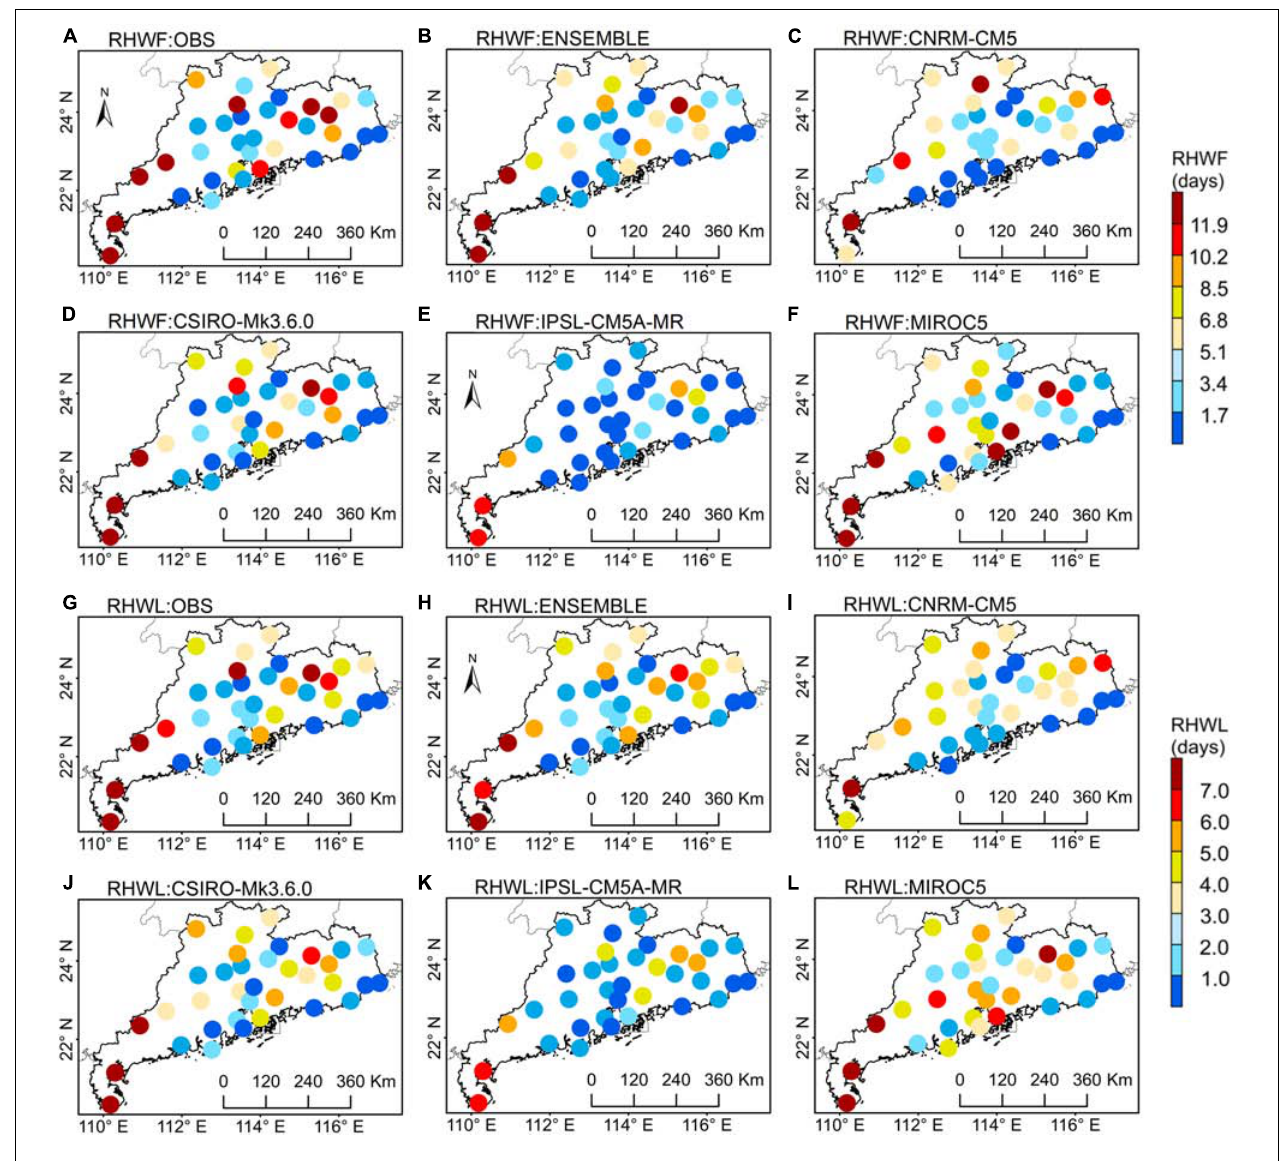
FIGURE 11 | Same as Figure 9 , but for RHWF ( A–F , unit: days) and RHWL ( G–L , unit: days).